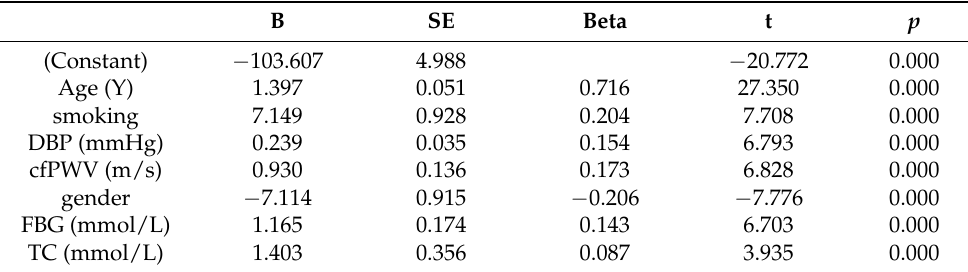
Table 3. Linear regression analysis of associations between ASCVD and cfPWV.